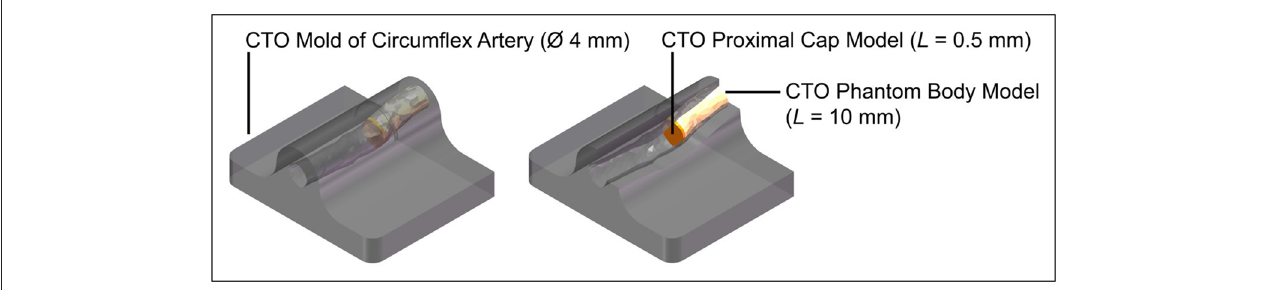
FIGURE 14 | Experimental facility: CTO phantom model. Color indications: gray = 3D-printed mold of the circumflex artery, yellow = CTO phantom model body, and orange = CTO phantom model proximal cap.